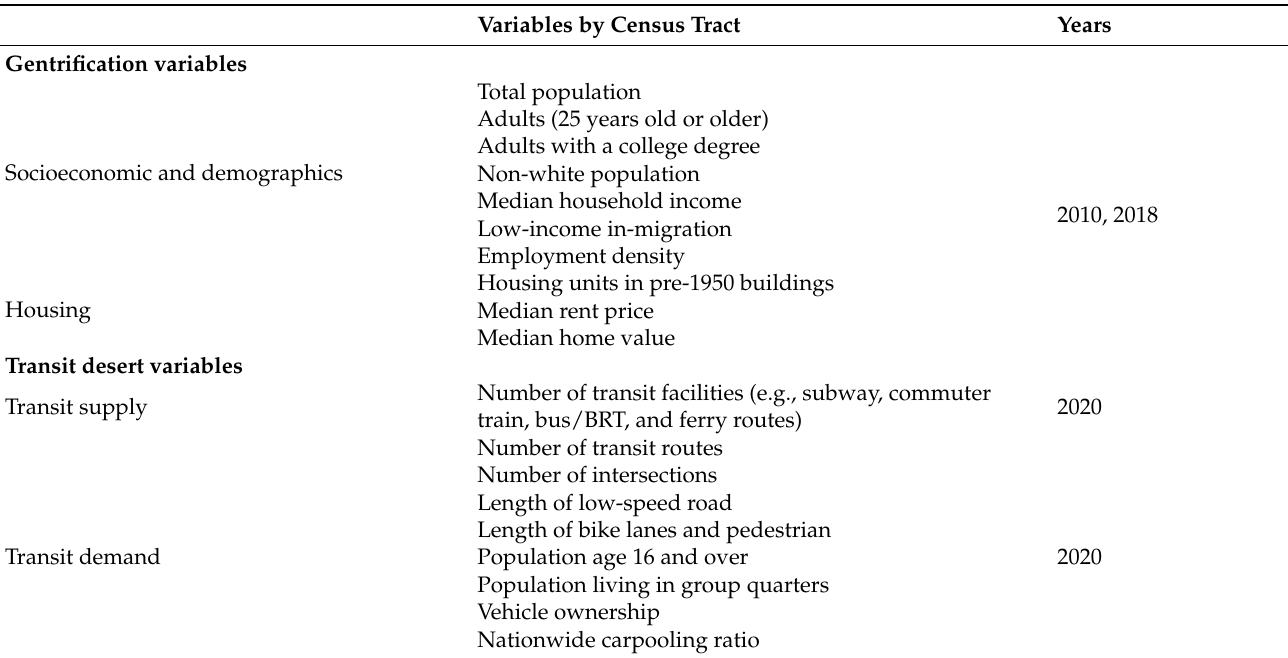
Table 1. Variables for gentrification and transit desert